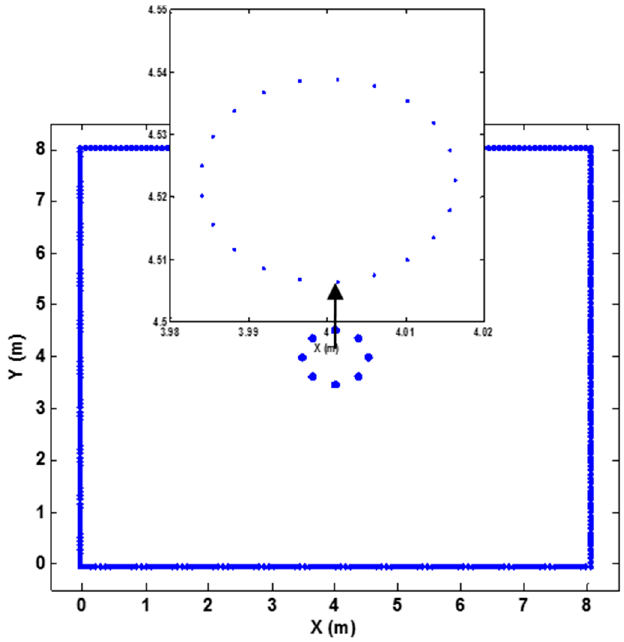
Figure 9. Simulation charge arrangement around an ideal smooth cylindrical conductor.